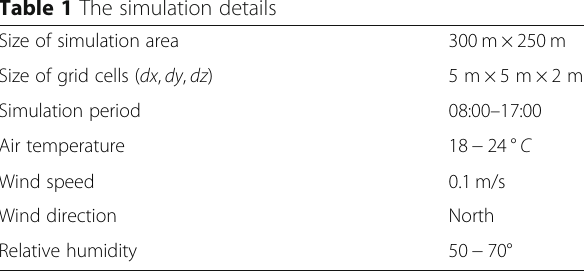
Table 1 The simulation